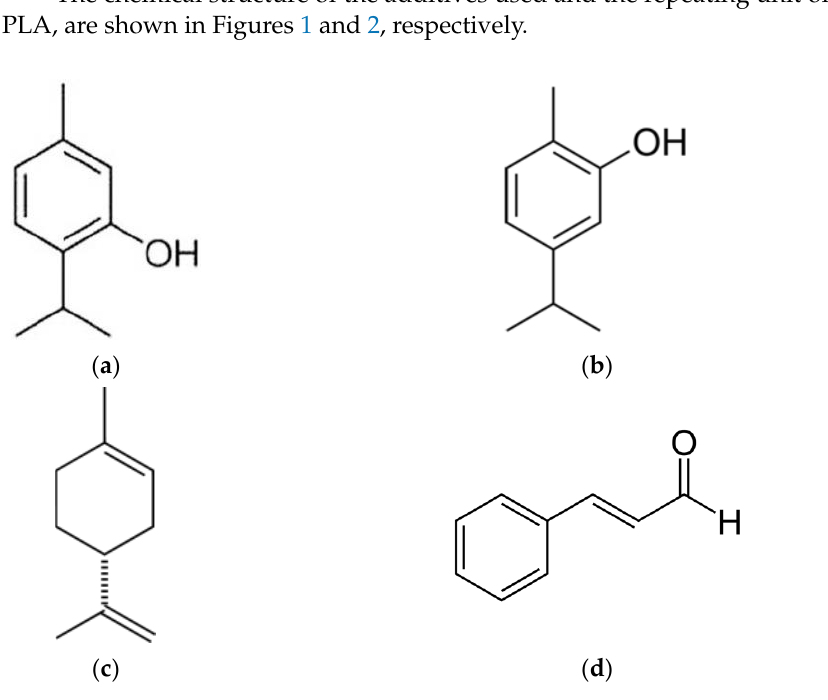
Figure 1. Chemical structure of ( a ) thymol, ( b ) carvacrol, ( c ) limonene and ( d ) cinnamaldehyde.